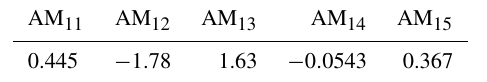
Table C1. Summary of nominal value for yaw model parameters: amplitude coefficients (dimensionless).